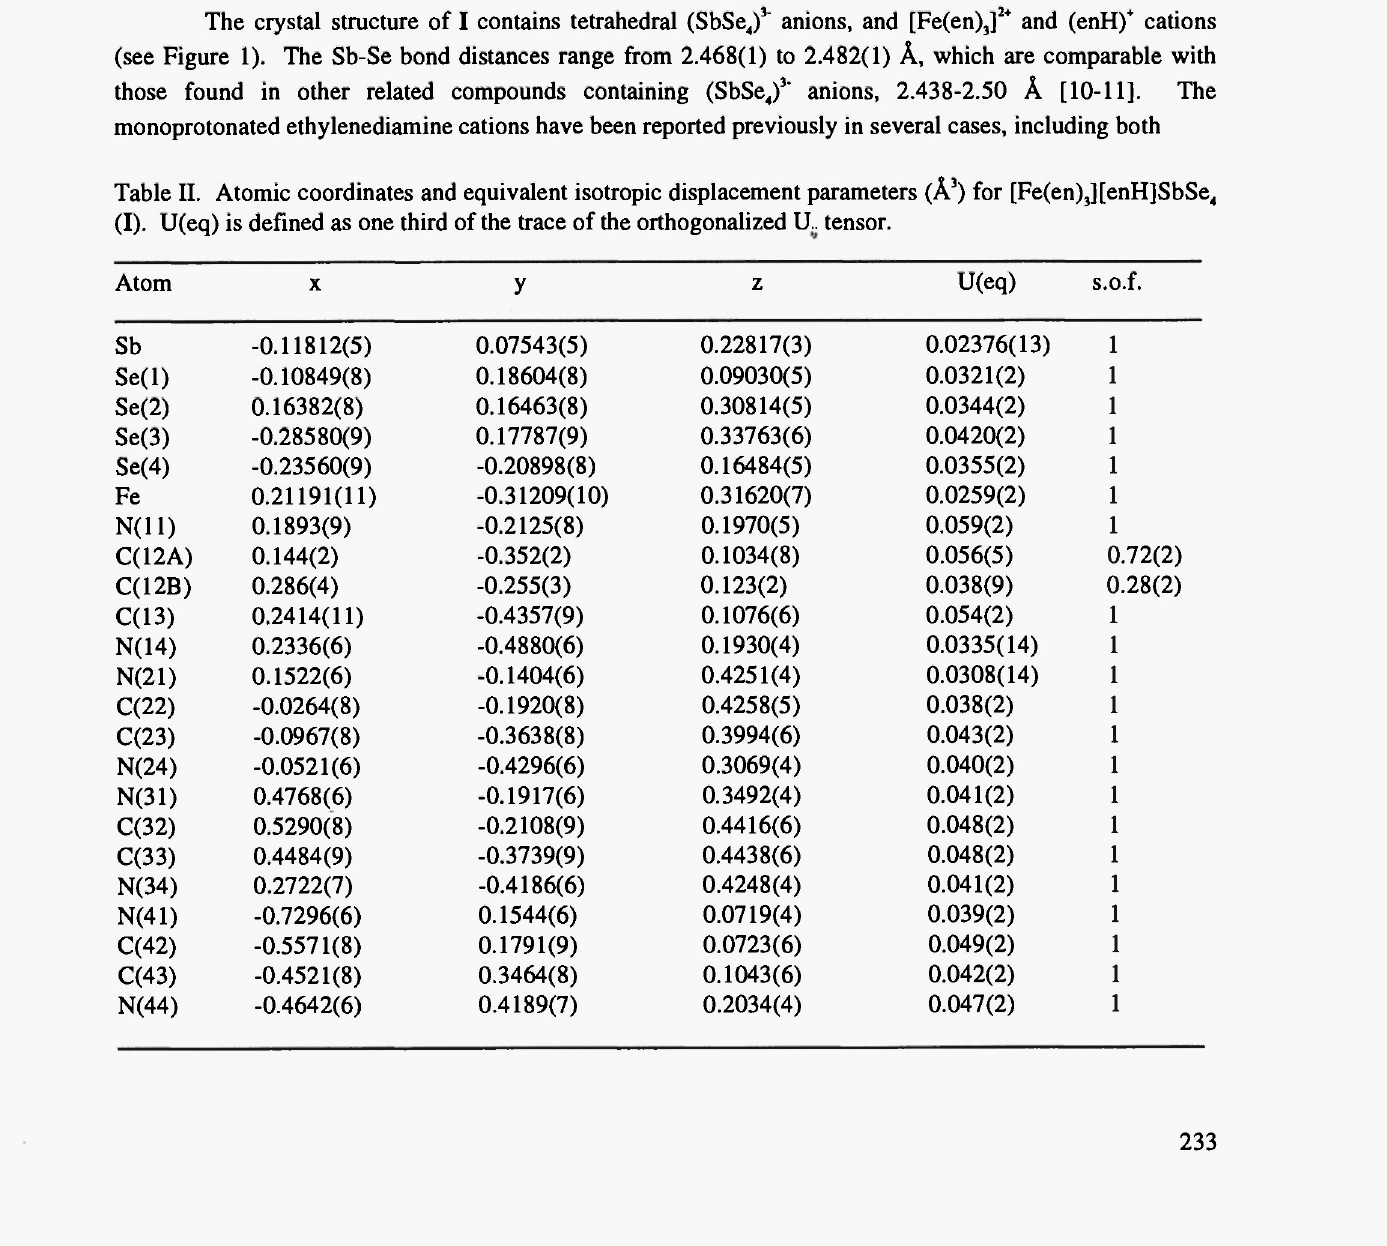
Table II. Atomic coordinates and equivalent isotropic displacement parameters (Ä 3 ) for [Fe(en) 3 ][enH]SbSe 4 (I). U(eq) is defined as one third of the trace of the orthogonalized LL